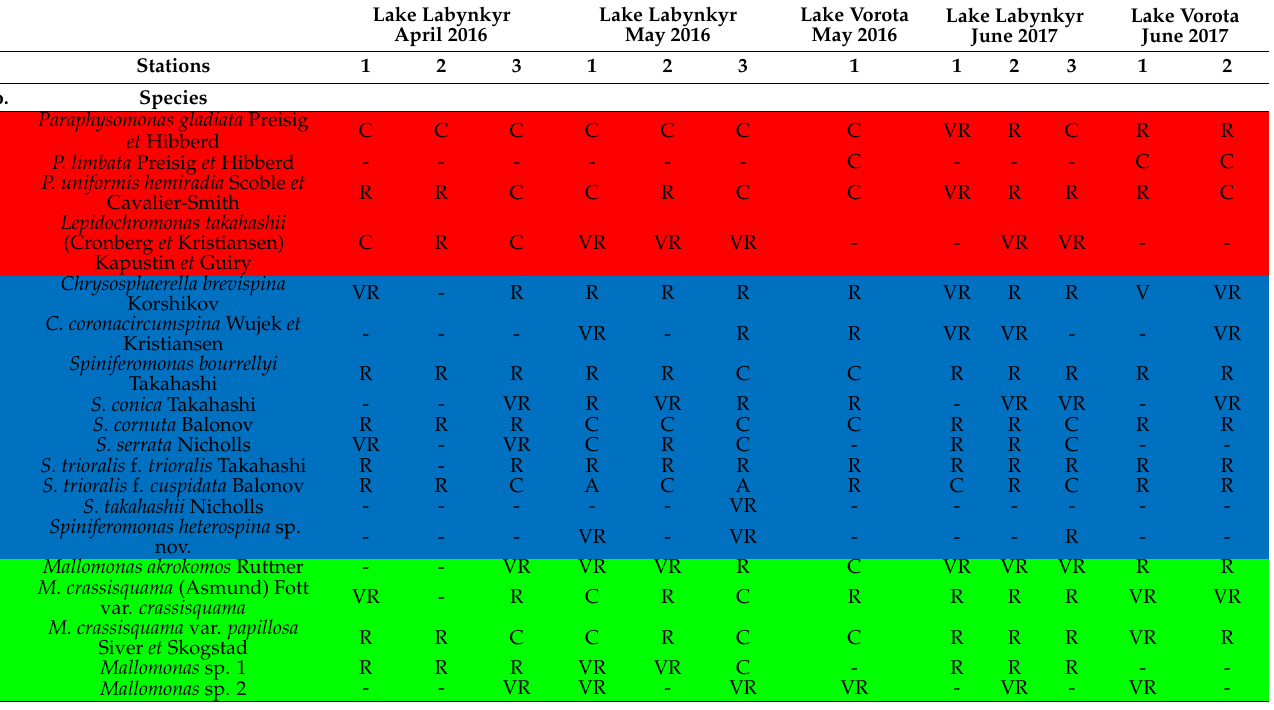
Table 1. Species composition of silica-scaled chrysophytes in the studied lakes (very rare (VR) 2–25 scales, rare (R) 26–50, common (C) 51–150, and abundant (A) >150). Mixotrophic—blue, heterotrophic—red,